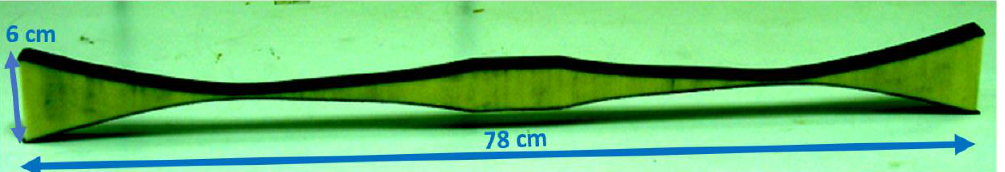
Figure 12. Final sandwich specimens design used in fatigue vibration (total length 78 cm, end height 6 cm).